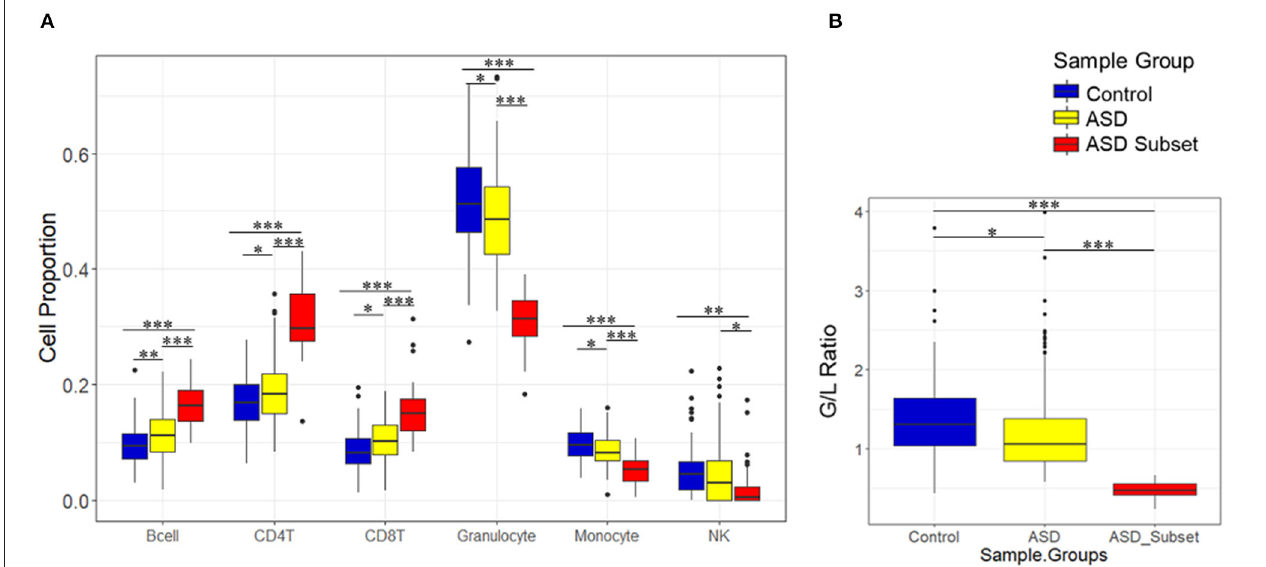
FIGURE 3 | Relative proportions of blood cell types in sample groups, as estimated by DNAm. Boxplots show immune blood cell proportions estimated by the Houseman method (A) and calculated granulocyte/lymphocyte (G/L) ratio (B) . Epigenetically unique ASD subset (red; n = 32), the remaining ASD cases (yellow; n = 233), and controls (blue; n = 122). ASD subset exhibited significant shifts in cell type proportions and the G/L ratio ( p -value < 0.01) as compared to the remaining ASD cases and controls. Black bars with asterisk represent significant differences in estimated blood cell proportions between the groups (* p ≤ 0.05; ** p ≤ 0.01; *** p ≤